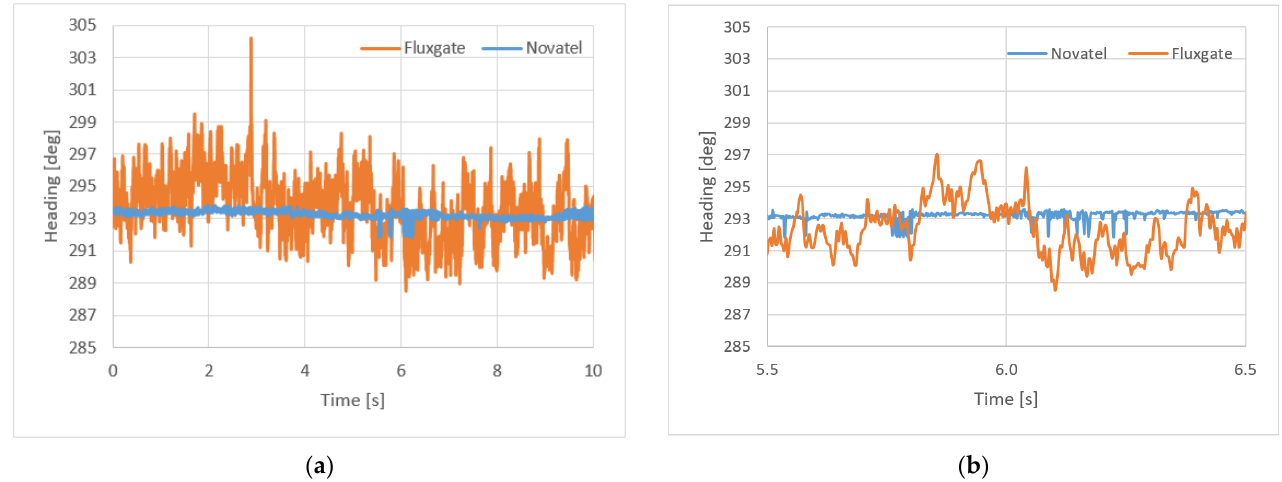
Figure 5. First 10 s of static measurements ( a ) and a period between 5.5 and 6.5 s ( b